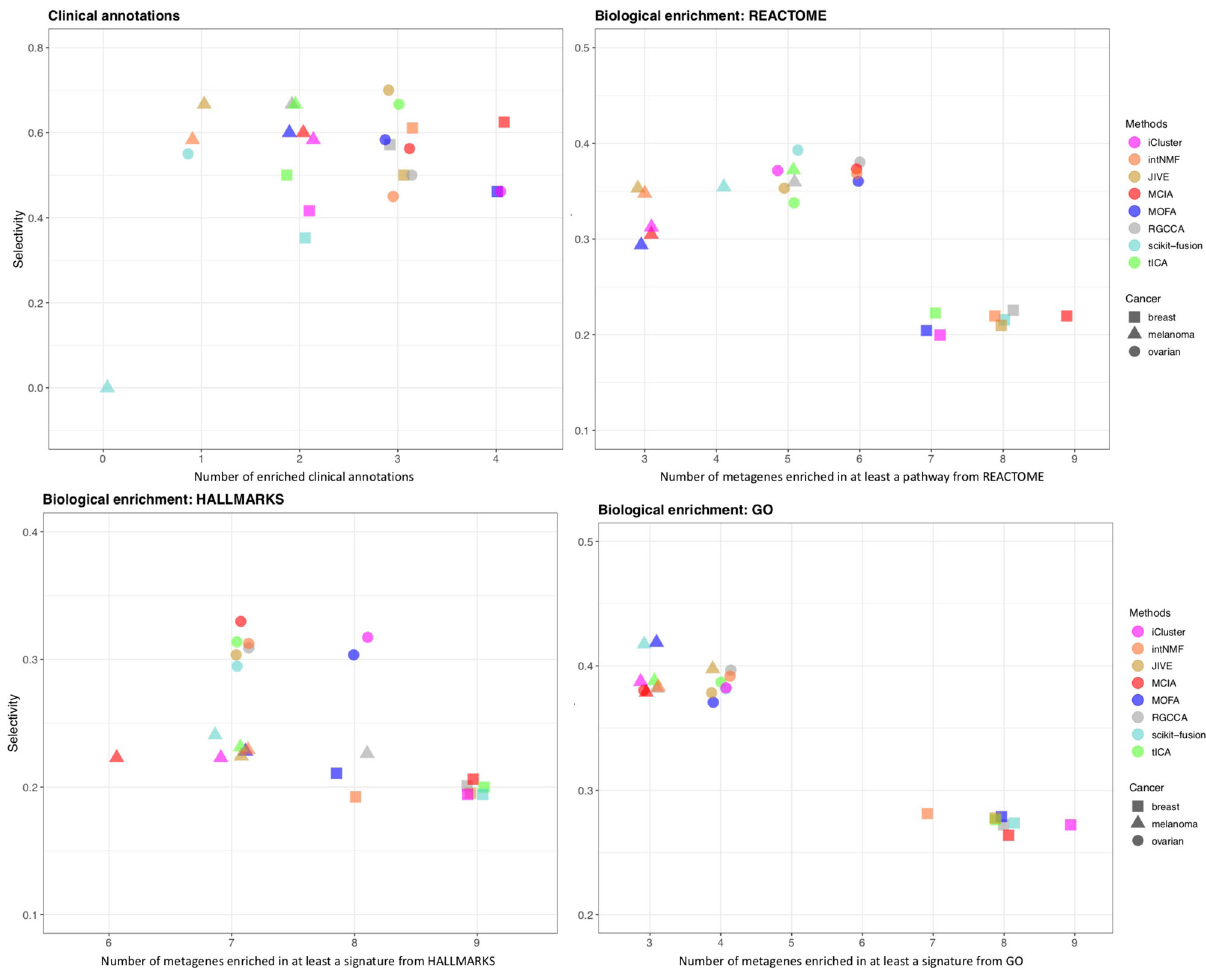
Fig. 6 Identi fi cation of factors associated with clinical annotations, and metagenes associated with biological annotations in ovarian, breast, and melanoma samples, by the jDR methods. For clinical annotations, the plot represents, for each method, the number of clinical annotations enriched in at least one factor together with the selectivity of the associations between the factors and the clinical annotations (Method). For the three annotation sources (MsigDB Hallmarks, REACTOME and Gene Ontology), the number of metagenes identi fi ed by the different jDR methods enriched in at least a biological annotation are plotted against the selectivity of the associations between the metagene and the annotation. See Supplementary Fig. 3 for the results corresponding to the other seven cancer